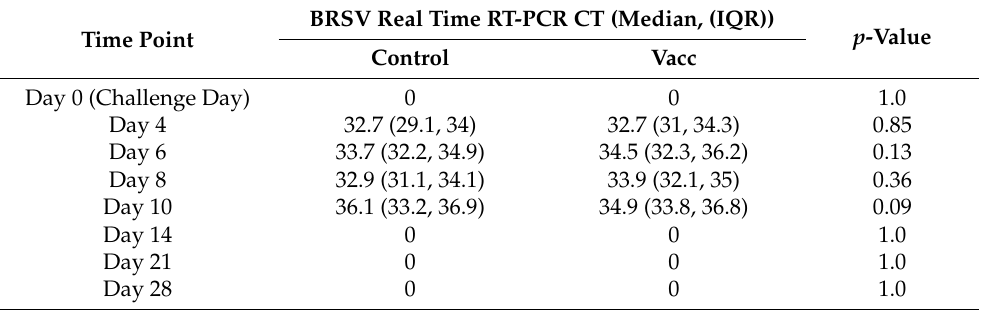
Table 1. Median and interquartile range (IQR) of cycle threshold (CT) values for BRSV in nasal secretion samples detected by real time-RT-PCR assay for Vacc versus Control calves as described in Figure 1 from challenge day (Day 0) to Day 28 of the